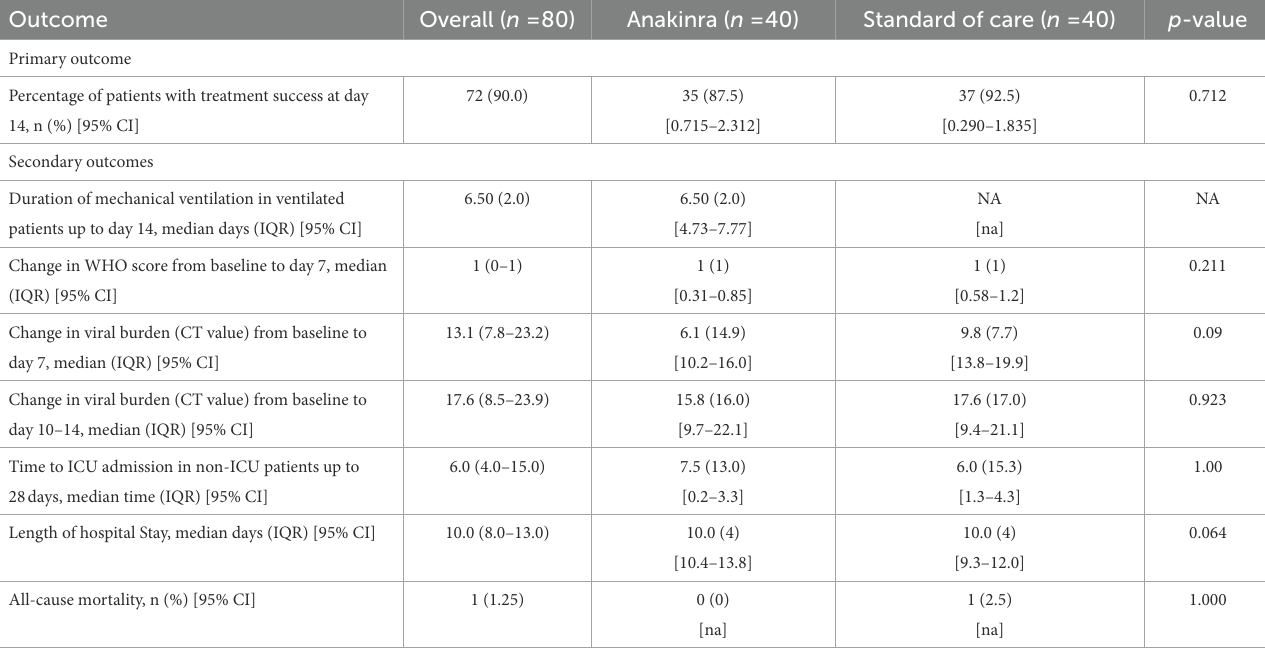
TABLE 2 Results of the primary and secondary outcomes. Outcome Primary